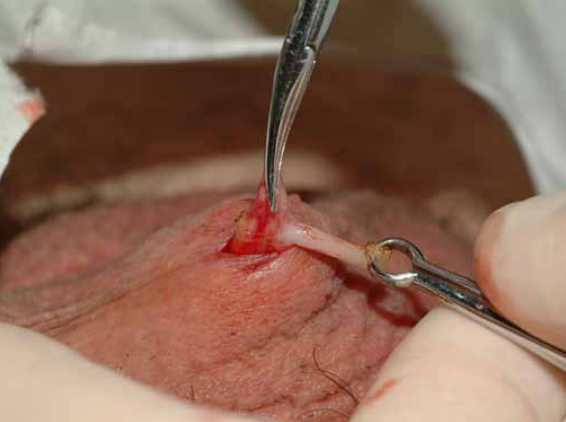
Figure 7 - Pulling on the testicular stump to completely separate the sheath covering the testicular stump.